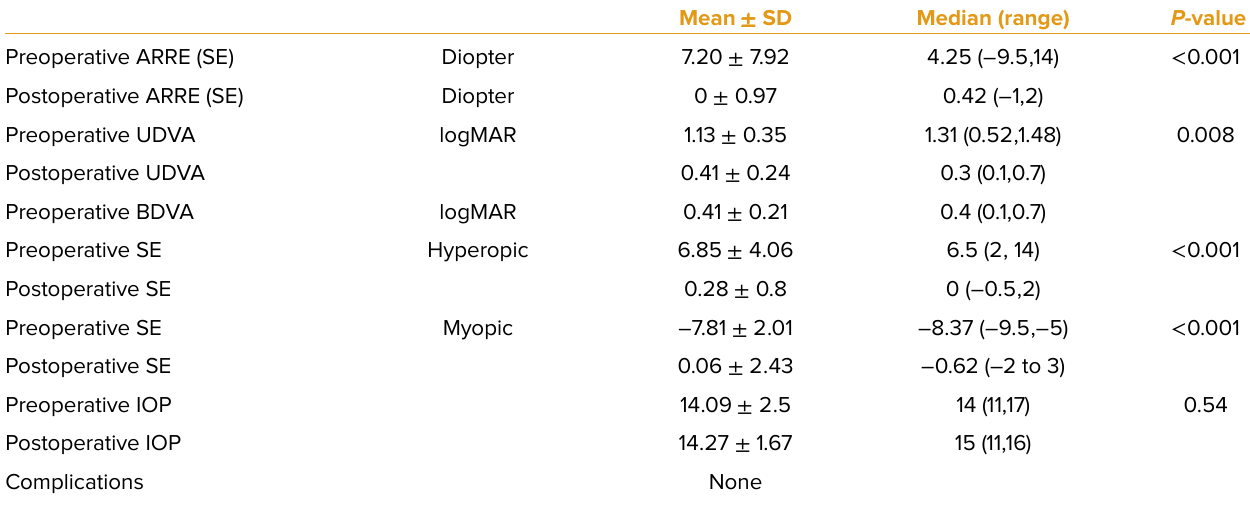
Table 3. Postoperative clinical outcome of the study